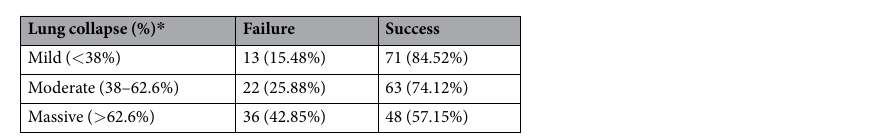
Table 2. Relationship between severity of pneumothorax size and treatment outcome. * Patients were divided into tertiles according to their initial pneumothorax size, as determined by chest